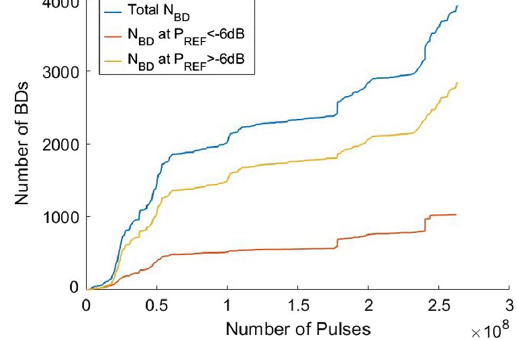
FIG. 13. Numbers of BDs with reflection coefficient P during the conditioning of the BTW